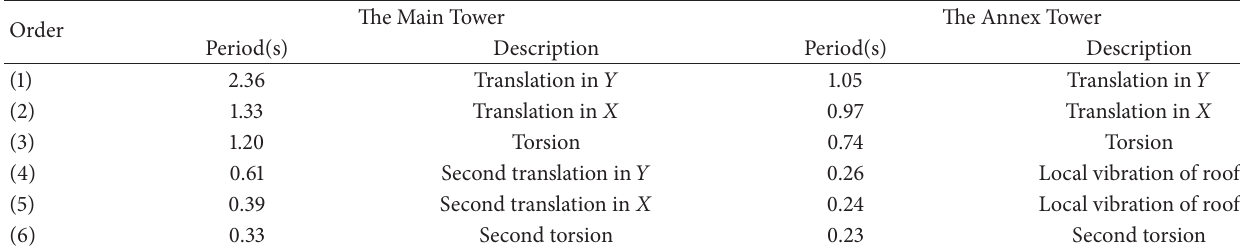
Table 3: Natural vibration periods of the Main Tower and Annex